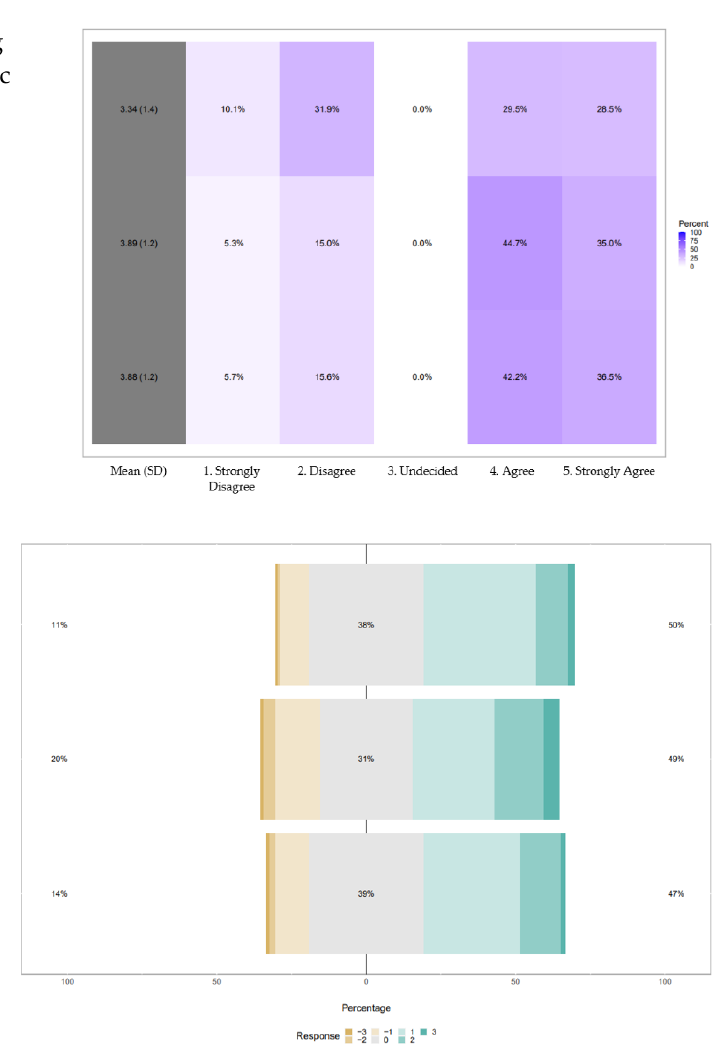
Figure 4. Second objective: post-test ( top ) and differences between pre-test and post-test ( bottom ). Own elaboration.